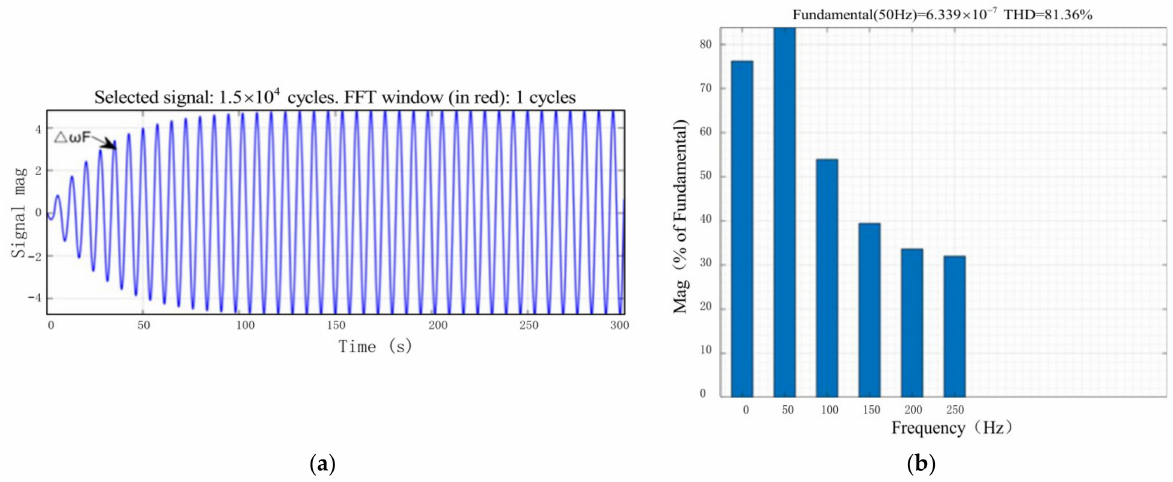
Figure 8. The speed difference caused by clearance and its frequency spectrum. ( a ) The waveform of the two-velocity deviation; ( b ) Frequency spectrum.